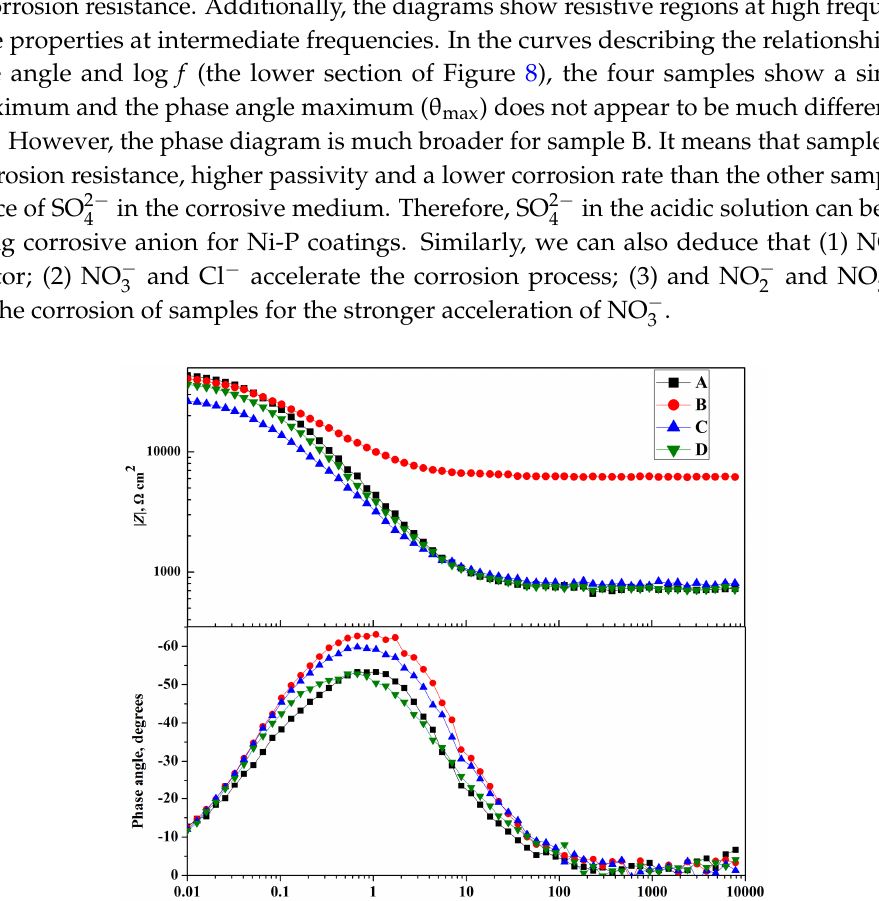
Figure 8. Bode plots for the samples in contact with the four solutions.